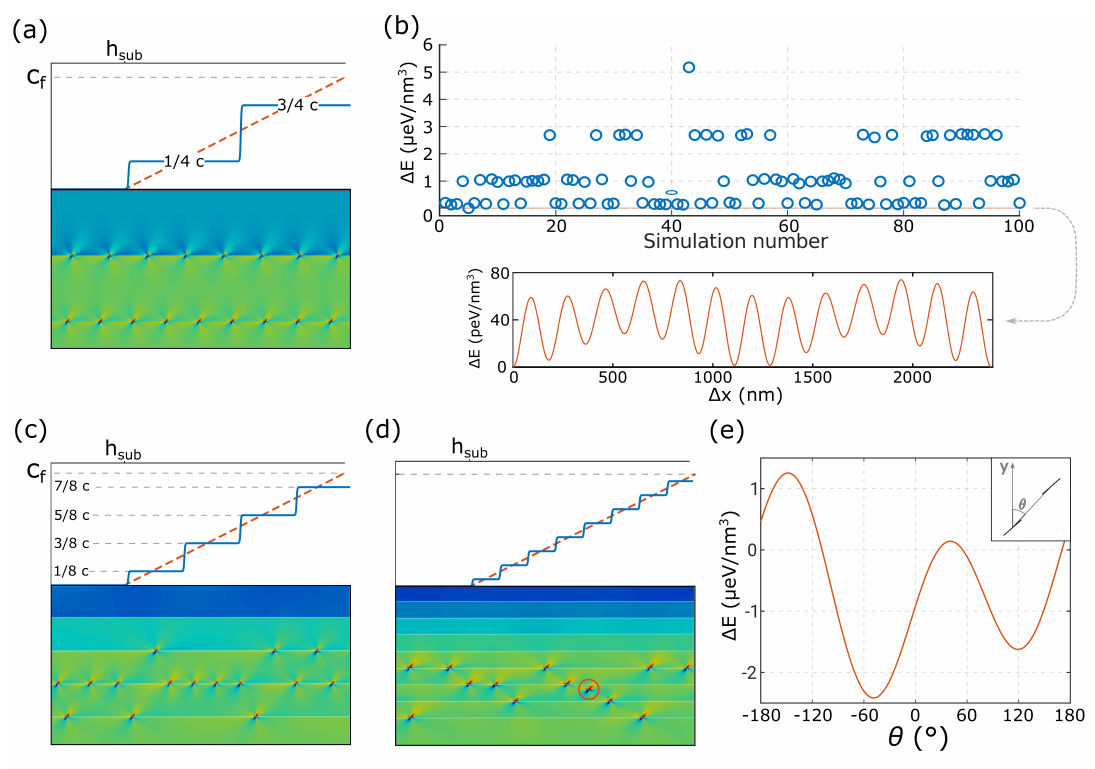
Figure 2. Evolution of the typical low-energy dislocation configurations with increasing number of concentration steps. ( a ) Two-step profile showing equispaced arrays of dislocations at the interfaces. ( b ) Local energy minima obtained from the unconstrained steepest descent procedure applied to 100 initial random dislocation configurations. In the inset is shown the energy variation for a rigid shift of the upper dislocation array with respect to the lower one. ( c ) Four-step profile, dislocations are still placed at the interfaces but start to organize themselves, losing the perfect spacing of the arrays. ( d ) Eight-step profile, pileup organization is more pronounced and dislocations begin to place outside the interfaces (red-circled dislocation). ( e ) Energy as function of the angle. The plot is obtained by considering two dislocations and moving one in circle around the other one as sketched in the